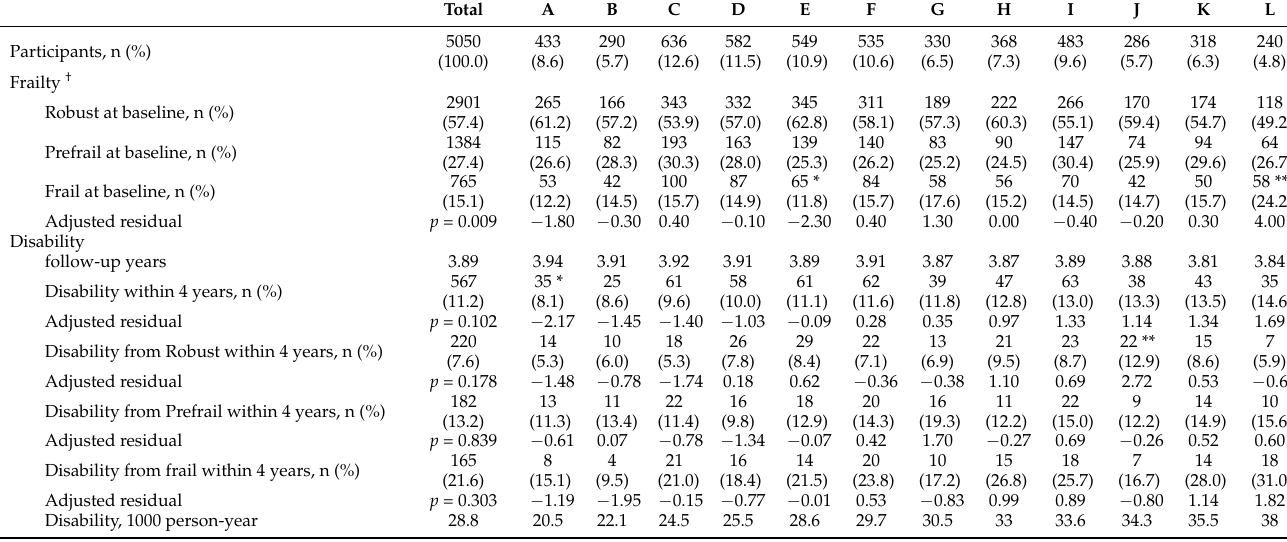
Table 2. Prevalence of Frailty and disability incidence among the